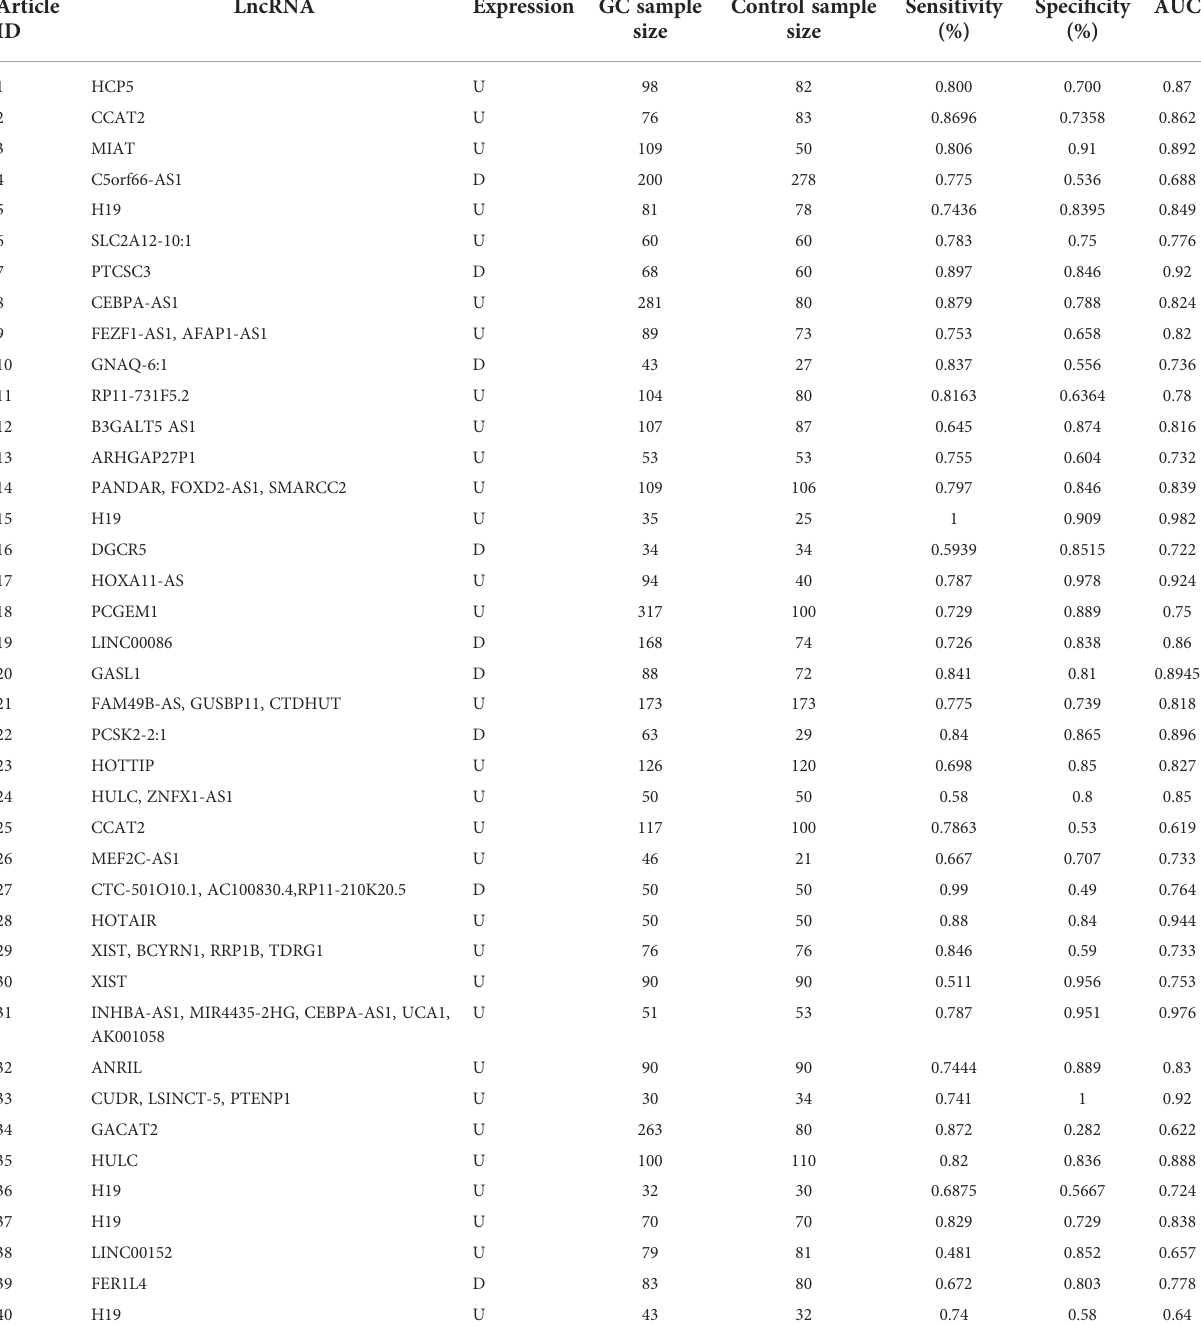
TABLE 2 Diagnostic accuracies of the lncRNAs mentioned in the